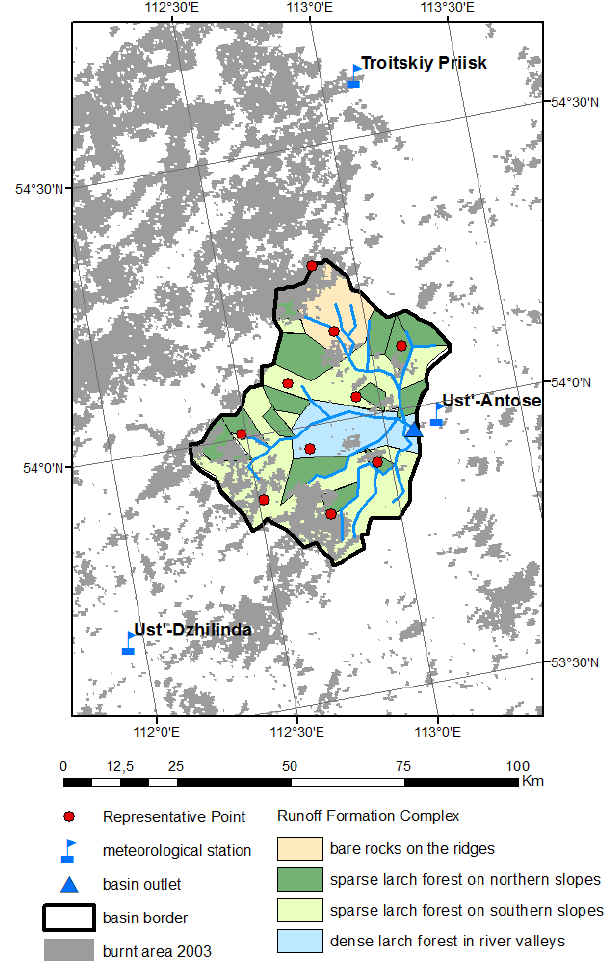
Figure 4. Schematization of the Amalat River basin for hydrologi- cal